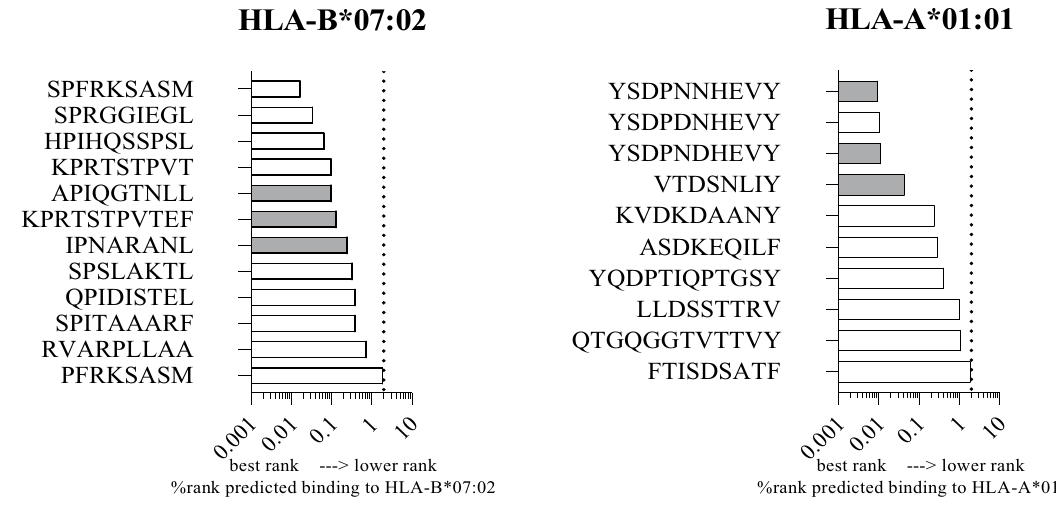
Figure 1. Predicted binding affinity of the candidate epitopes to HLA and capability to induce cytokine production by T cells Mumps virus (MuV) candidate epitopes were selected based on their predicted binding (threshold rank < 2%) to HLA-B*07:02 molecule (left panel; n = 12 peptides) and HLA-A*01:01 molecule (right panel; n = 10 peptides). Selected peptides were used to stimulate peripheral blood mononuclear cells (PBMC) of respectively three HLA-B*0702 positive and three HLA-A*01:01 positive mumps patients. CD8 + T effector cell lines from these patients were stimulated with the selected peptides and production of interferon (IFN)-γ and tumor necrosis factor (TNF) by CD8 + T cells was measured by flow cytometry. Peptide-reactive T cells were identified as a twofold increase of IFNγ + /TNF + cells within the CD3 + /CD4 - /CD8 + live gate in comparison